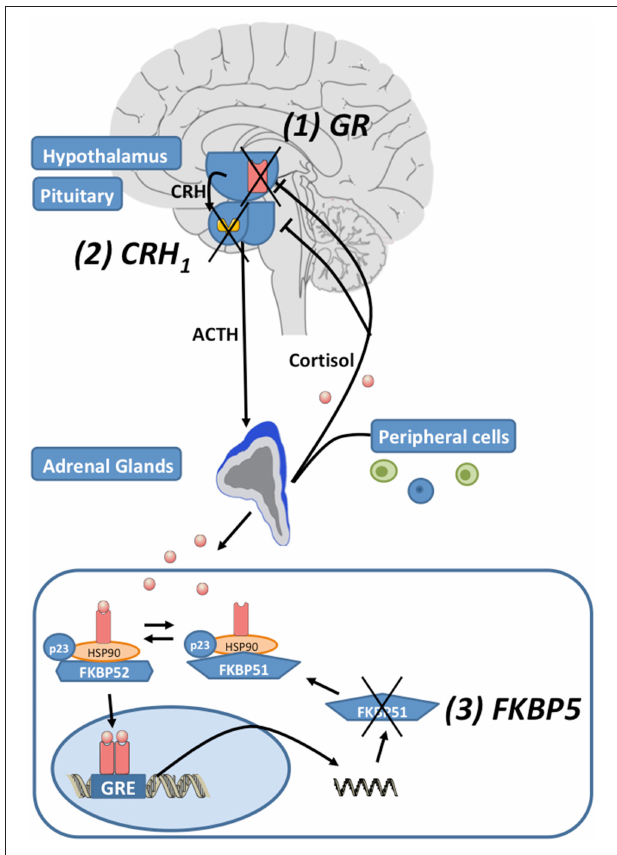
FIGURE 1 | The hypothalamic-pituitary-adrenal (HPA) axis: Corticotropin-releasing hormone (CRH) is released by neurons in the paraventricular nucleus of the hypothalamus. Subsequently CRH 1 receptors are activated and the secretion of adrenocorticotropic hormone (ACTH) from the pituitary is induced. ACTH induces the release of glucocorticoids (cortisol) by the adrenal glands. After the activation of the HPA axis, negative feedback loops are activated to reinstate homeostasis by cortisol activating glucocorticoid receptors (GR). The unliganded GR complex consists of the co-chaperones FKBP51 or FKBP52 (encoded by their respective genes FKBP5 and FKBP4 ), p23 (a co-chaperone molecule) and hsp90 dimer. When FKBP51 binds to the GR-complex via hsp90, the GR affinity for cortisol is reduced. When glucocorticoids bind to the GR, FKBP51 is exchanged against FKBP52 and the nuclear translocation of the ligand-bound GR is enabled. The GR directly binds to the DNA via glucocorticoid response elements (GREs) and induces FKBP5 mRNA expression and subsequently FKBP51 production, inducing an ultra-short negative feedback loop on GR sensitivity. Drugs regulating the function of the HPA axis target: (1) the GR, (2) the CRH 1 receptors, and (3) FKBP5 /FKBP51 (modified after Leistner and Menke (21); Copyright (2018), with permission from